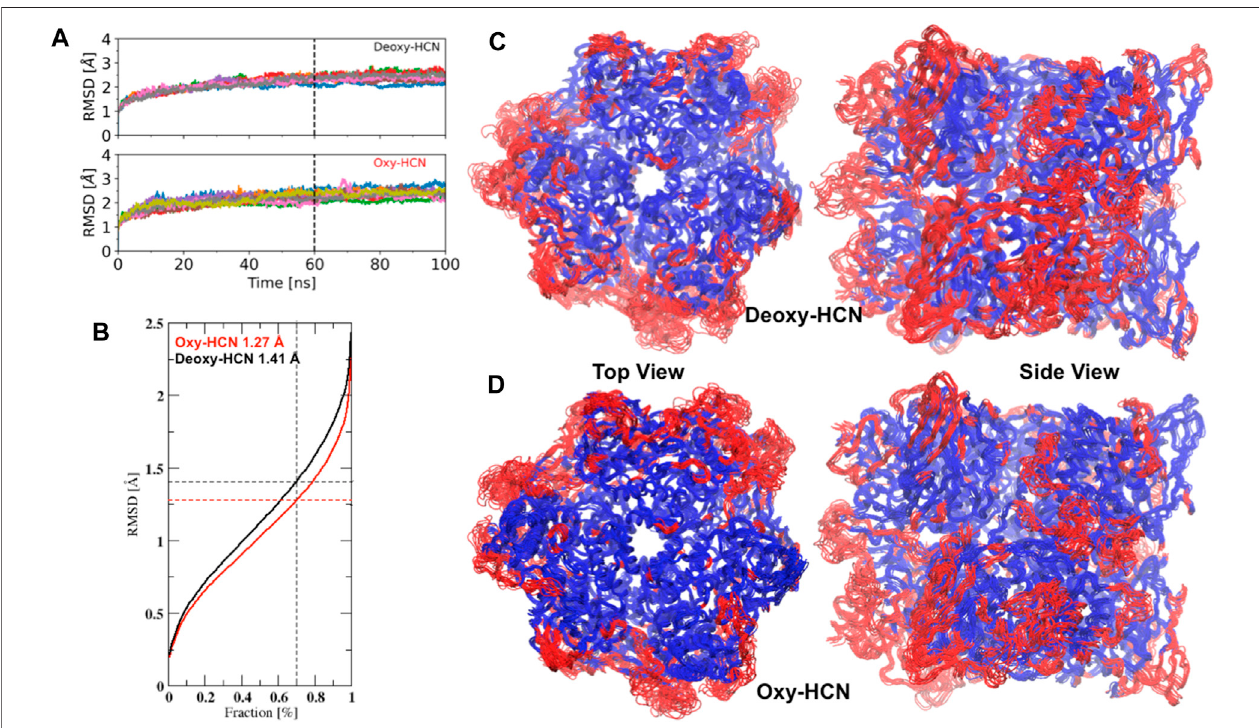
FIGURE 4 | A comparison of C α conformational drifts between the deoxygenated and oxygenated hemocyanin hexamers. (A) Average C α RMSD for Deoxy-HCN (2.55Å ± 0.04) and Oxy-HCN (2.43Å ± 0.04) aresimilarwhen calculated over thelast 40ns equilibrated section ofthe trajectories. (B) 70%of C α atoms in the simulation canbealignedtobelow1.41 ÅinDeoxy-HCN(black)and 1.27 ÅinOxy-HCN(red). Topand sideviewsof (C) Oxy-HCNand (D) Deoxy-HCN structures,highlightingthe leastmobileC α atoms(70%)thatformthecore(blue).Theregionsofthestructure,whicharemoremobile(red)includethesurfaceloopsorshortloopsthatconnect different secondary structure elements